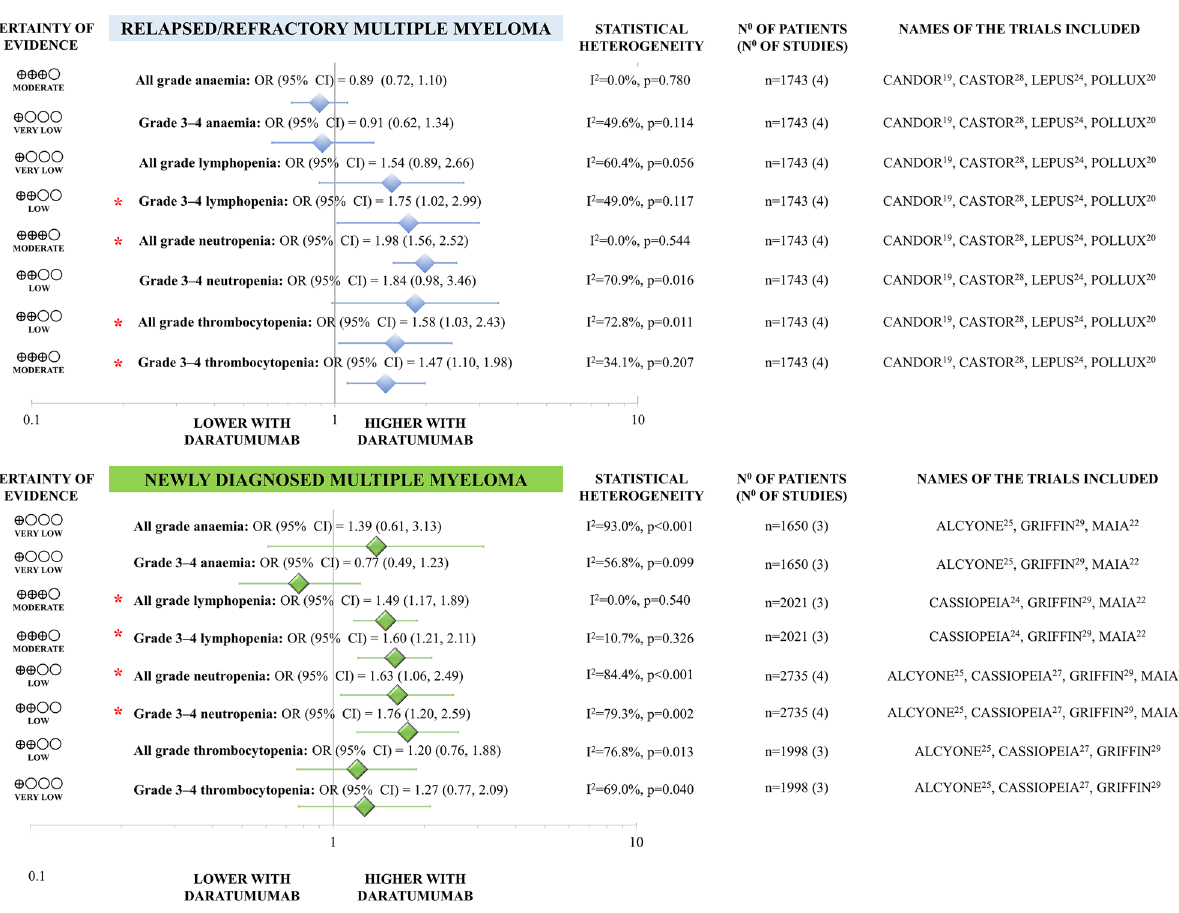
Safety. Figure 3 summarises the results of the meta-analyses on haematological toxicity. Grade 3–4 lympho- penia, all grade neutropenia, and all grade and grade 3–4 thrombocytopenia were more common with dara- tumumab-containing vs control treatment (with statistical power ≥ 80%). We failed to detect a significant dif- ference between the groups regarding other haematological toxicities. However, the comparison of all grade lymphopenia and grade 3–4 anaemia had less than 80% statistical power. We have not found difference in all grade (OR 2.21, CI 0.92–5.29, with statistical power ≥ 80%) and grade 3–4 hypertension (OR 3.21, CI 0.97–10.61, with statistical power ≥ 80%). Data were insufficient for meta-analysis in the case of peripheral neuropathy and second primary malignan- cies (two non-overlapping study populations each); and in the case of acute cardiac failure, acute renal failure, ischemic heart disease (one non-overlapping population each) (shown in Table 2), and haematological toxicity in cytogenetic subgroups (two non-overlapping study populations each) (shown in Table 3).